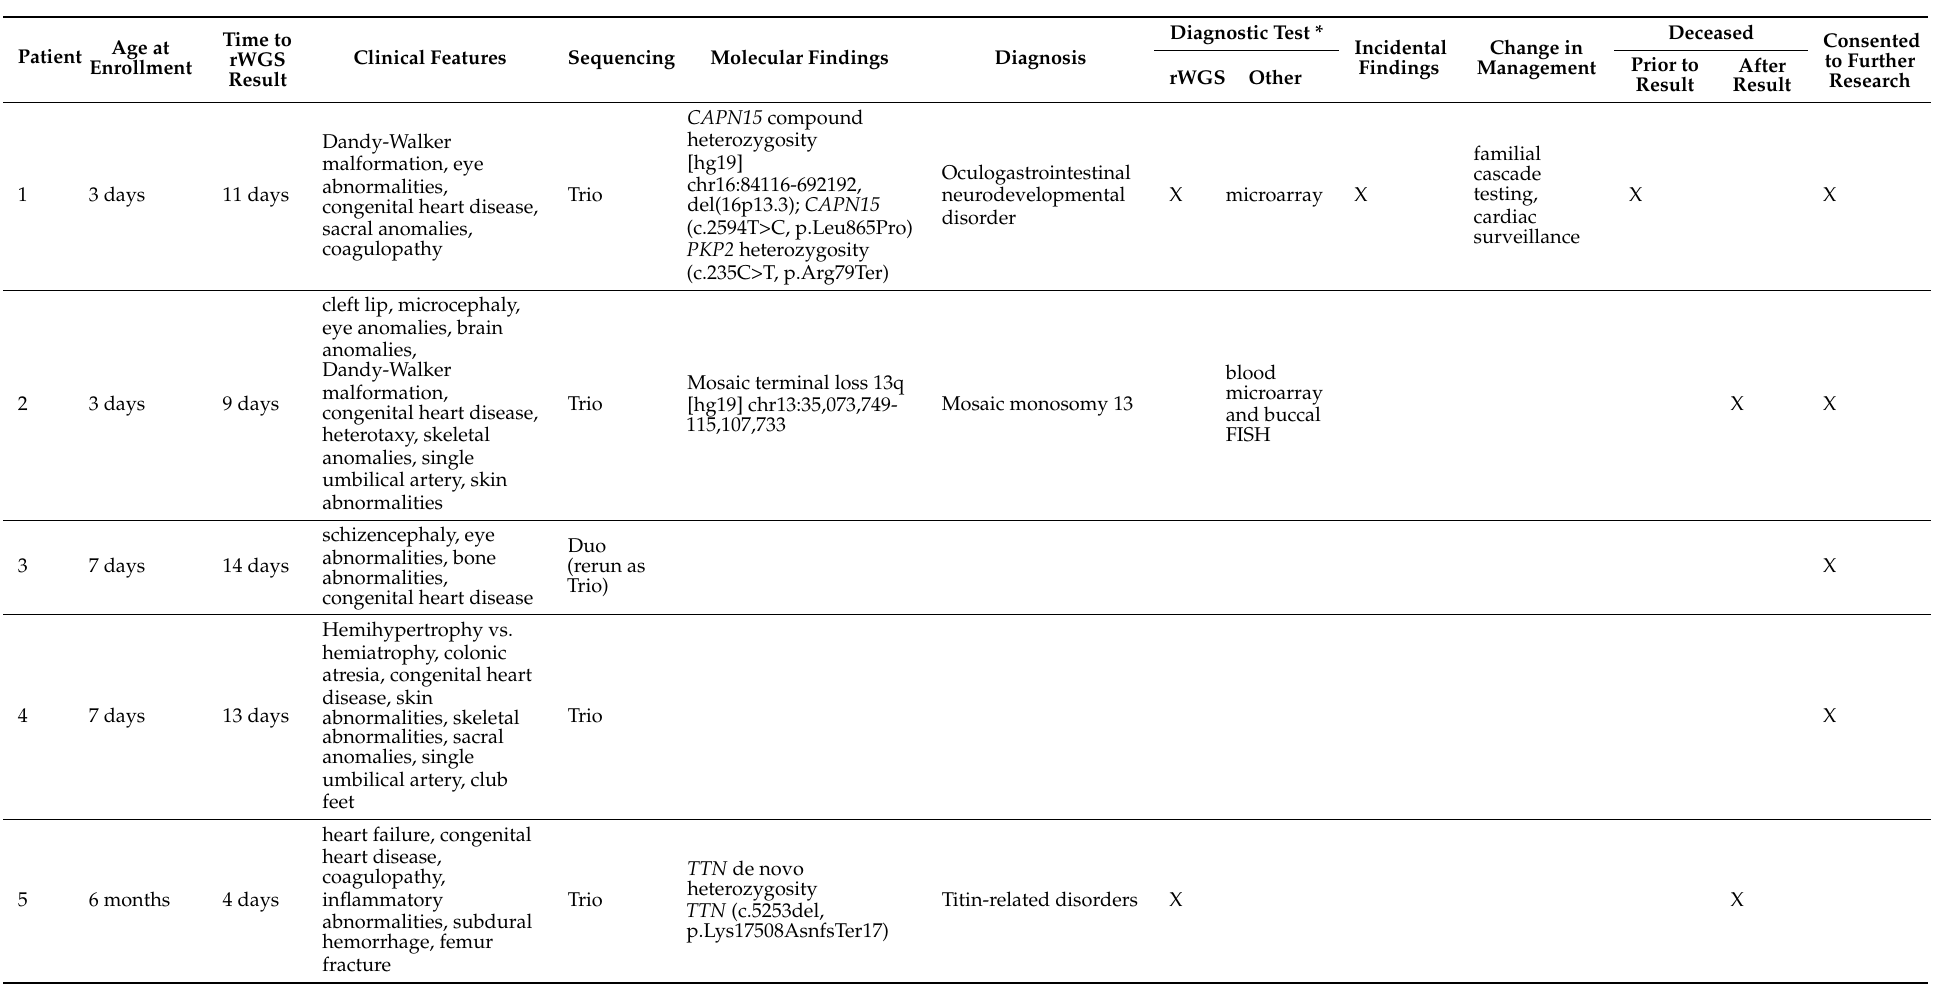
Table 2. Detailed clinical summary and genetic testing results of all patients enrolled in the study. rWGS: rapid whole genome sequencing; FISH: fluorescence in situ